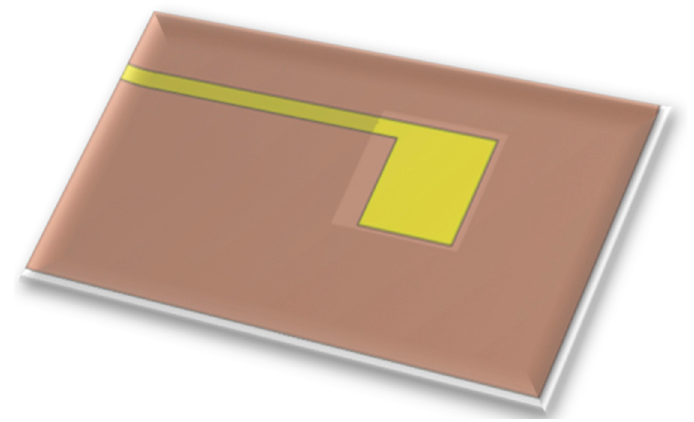
Figure 3. Schematic diagram of voltage sensor.